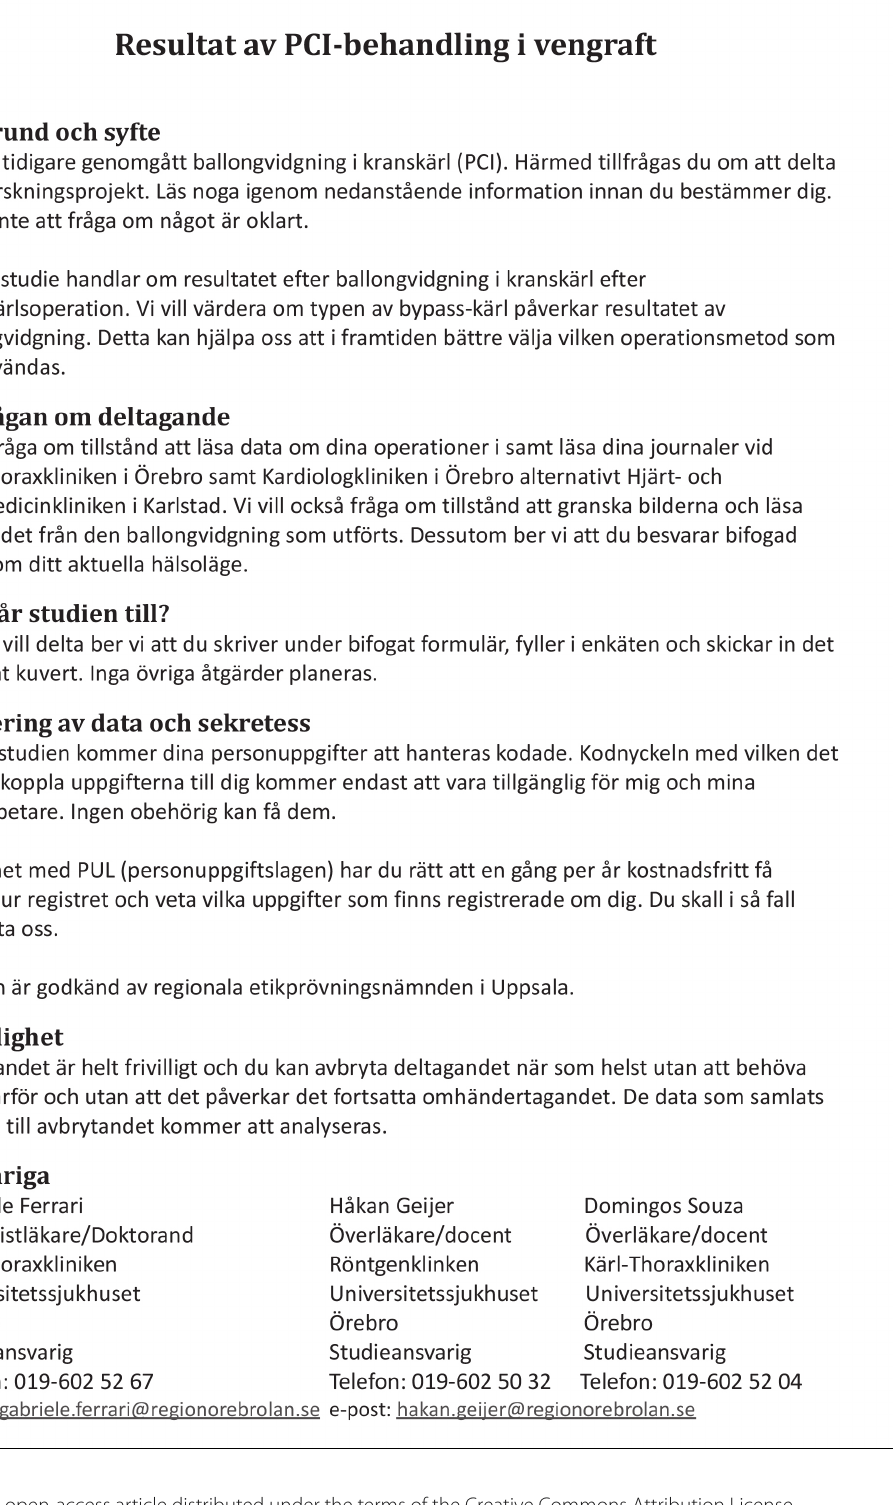
Supplementary 1 - Patient Consensus (in original